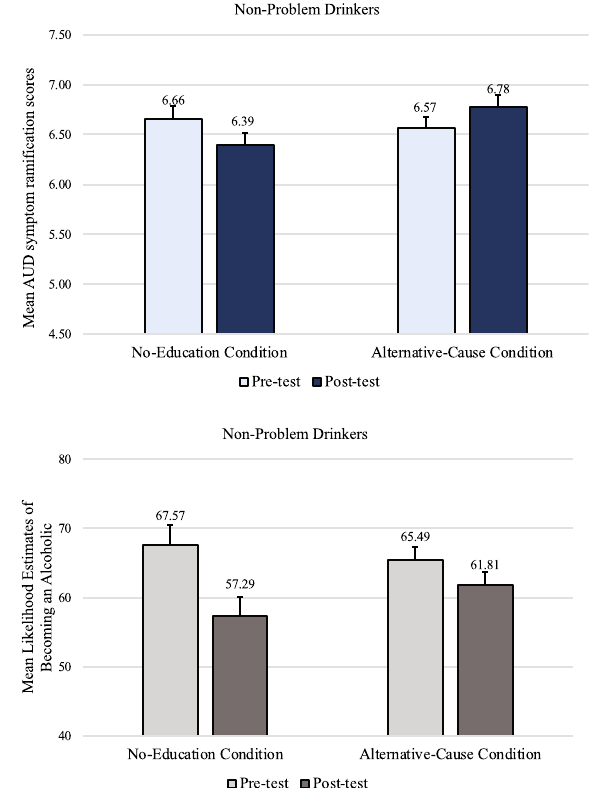
Figure 2. Non-problem-drinkers’ mean AUD symptom ramification scores and mean likelihood estimates of becoming an alcoholic in Study 1, by condition at pre-test and post-test. Error bars represent SEM pairedDiff